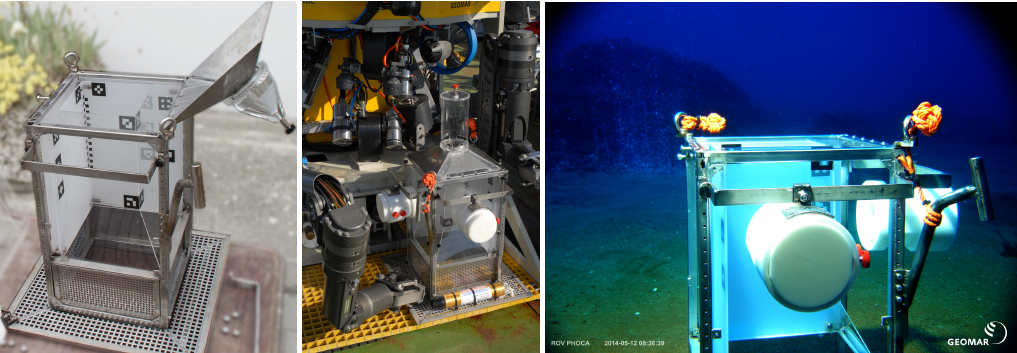
Figure 2. Three views of the bubble box, from left to right : box without cameras during development, box on ROV Phoca before being deployed (research cruise on RV Poseidon) and box in shallow water near Panarea, an area with heavy carbon dioxide